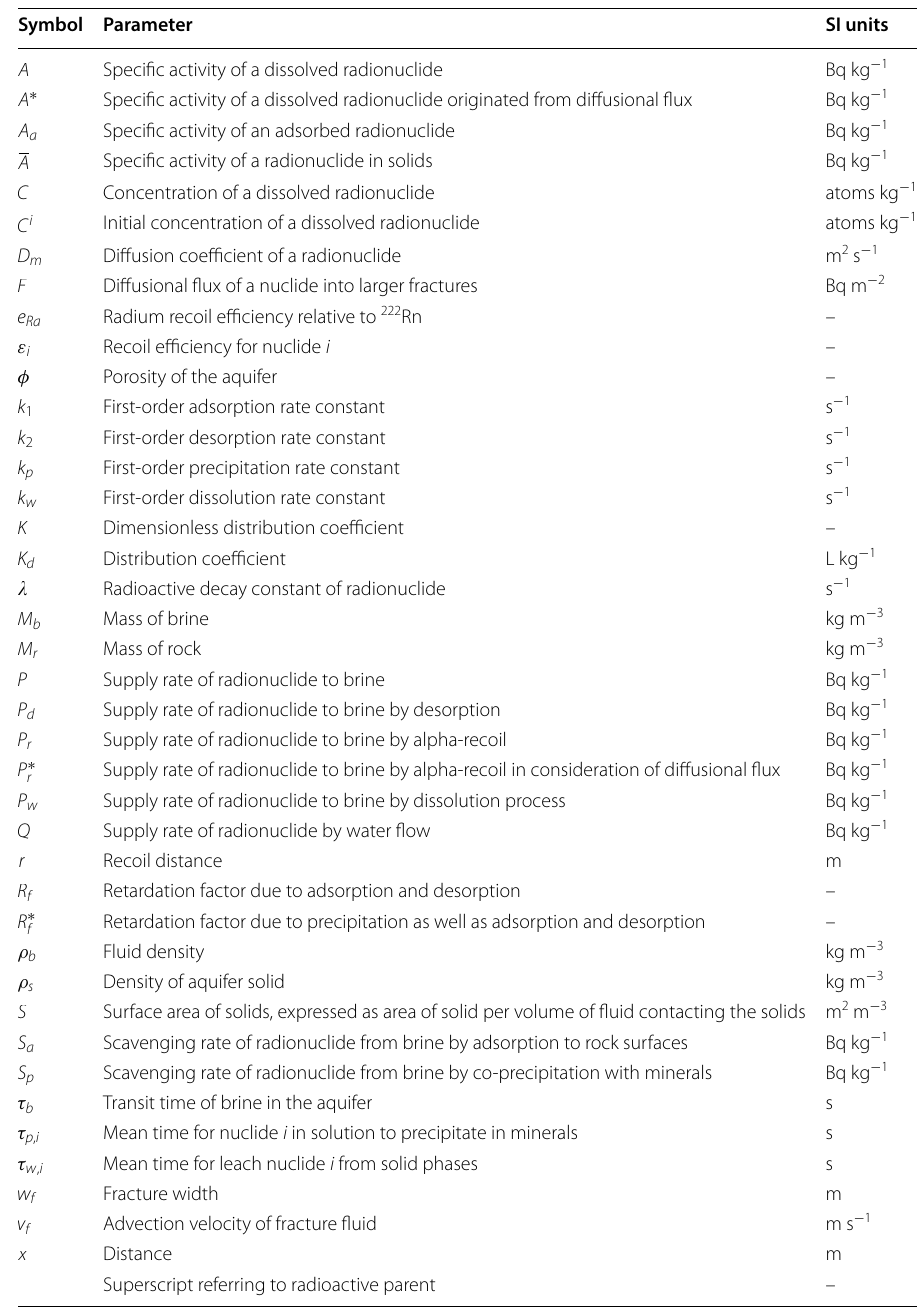
Table 7 Parameters used in the water–rock interaction model (Ku et al. 1992) Symbol Parameter SI